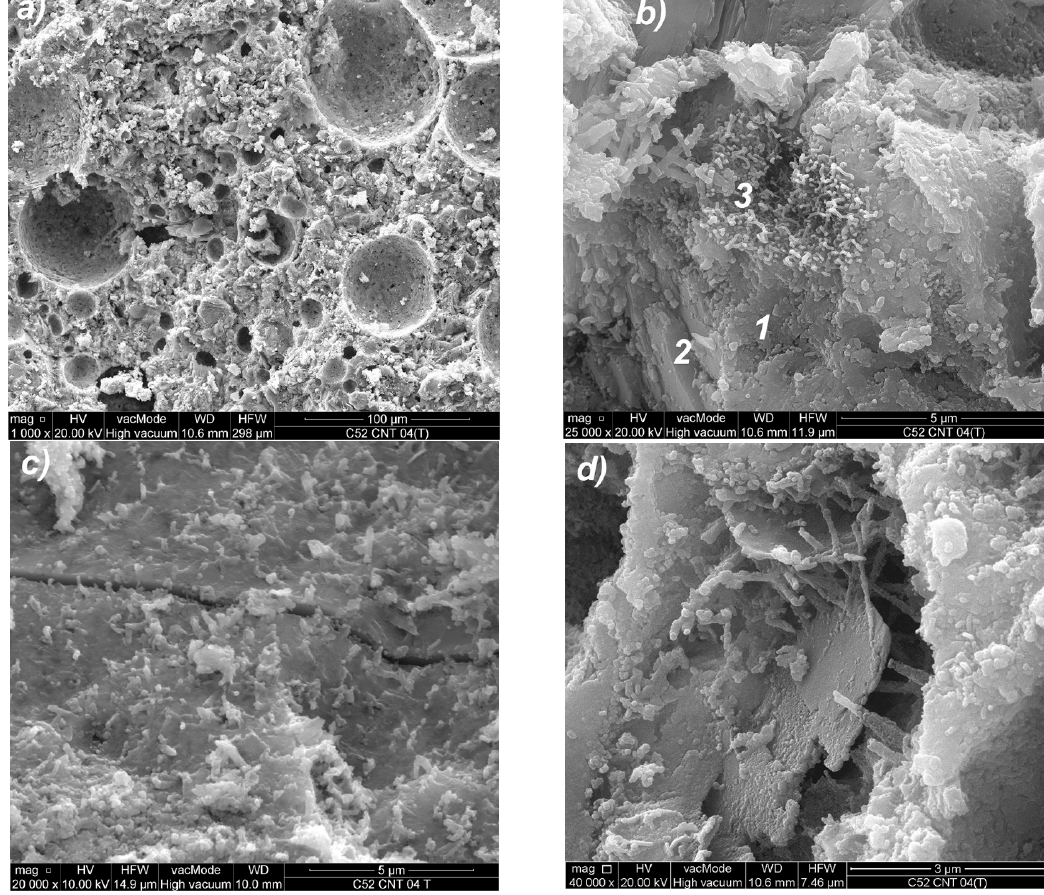
Figure 18. SEM photos of the C52CNT cement paste microstructure (descriptions of the indications in the text) for ( a ) magnification 1000×; ( b ) magnification 25,000×; ( c ) magnification 20,000×; ( d ) magnification 40,000×.